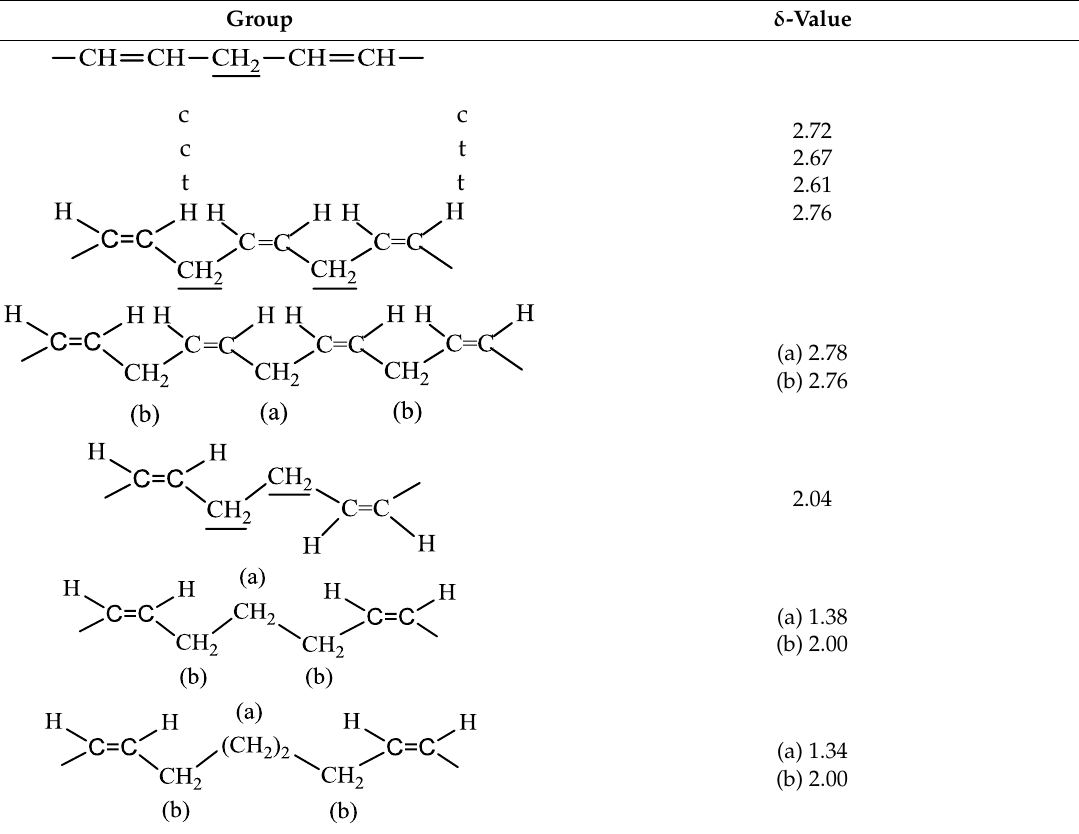
Table 7. 1 H-NMR features of some characteristic groups in polyenoic fatty acids and esters (in CC1 4 ). Reprinted, with permission, from [54]. Copyright 1975, North-Holland Publishing Company.